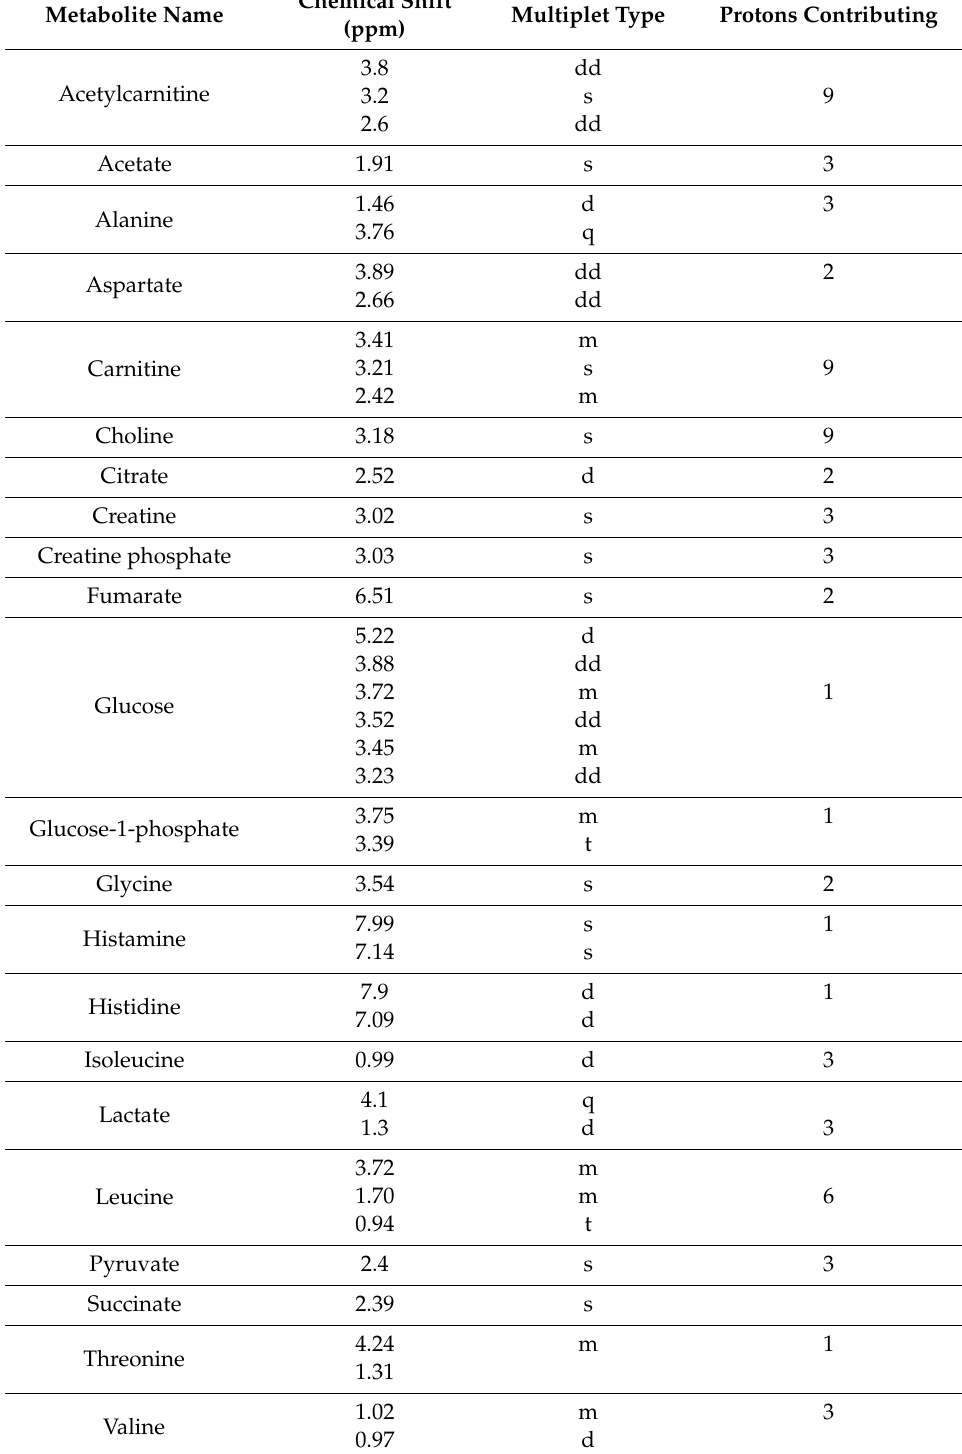
Table 1. Chemical shift assignment, multiplicity, and number of contributing protons for the identified